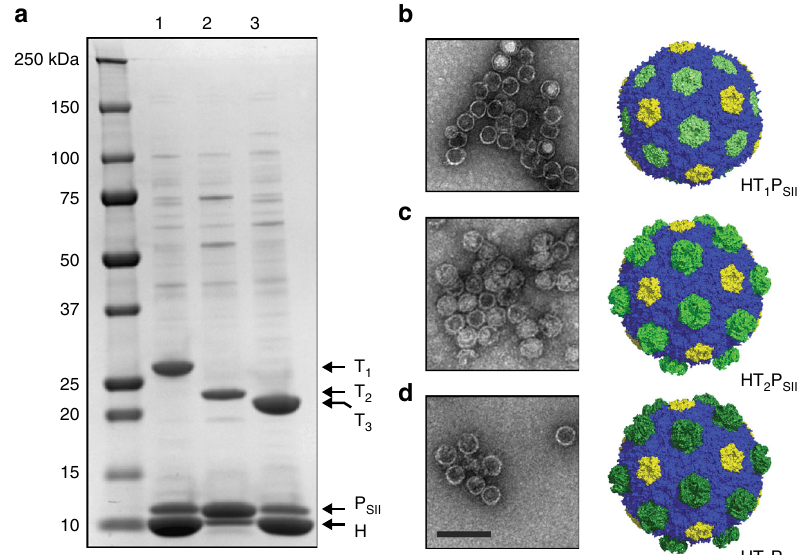
Fig. 2 Comparison of different minimal shells. a SDS-PAGE analysis of crude shell preparations. Lane 1: HT 1 P SII Lane 2: HT 2 P SII Lane 3: HT 3 P SII . Shell protein identities indicated by arrows. b – d Negative stain TEM micrographs of three minimal shell preparations and corresponding structural models. Scale bar